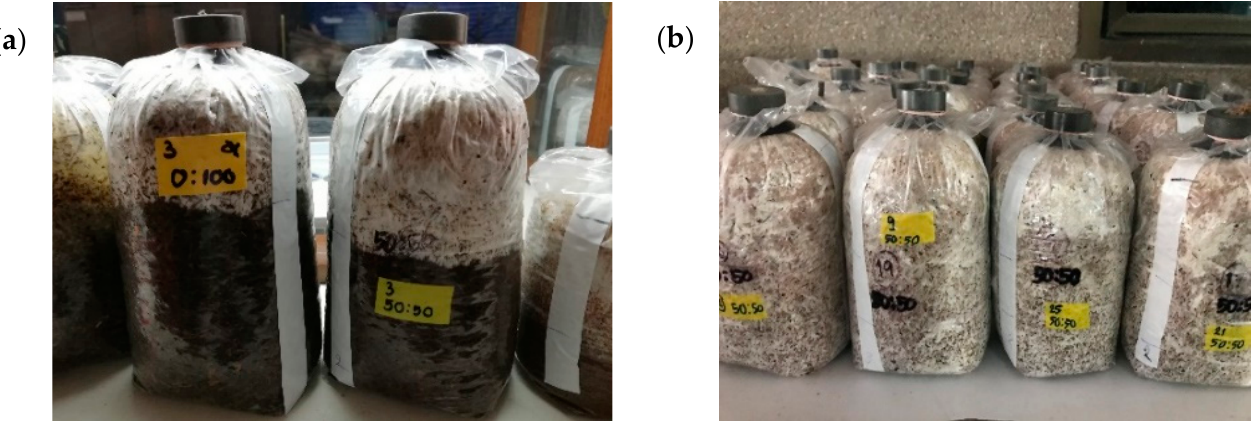
Figure 2 . P. sajor-caju mycelia growing on cylindrical baglog ( a ) left, M-LBS and right, M-LBT (1:1) at 7 days and ( b ) showing full colonization of four treatments, M-LBS, M-LBS (1:1), D-LBS, and D-LBS (1:1) from left to right.